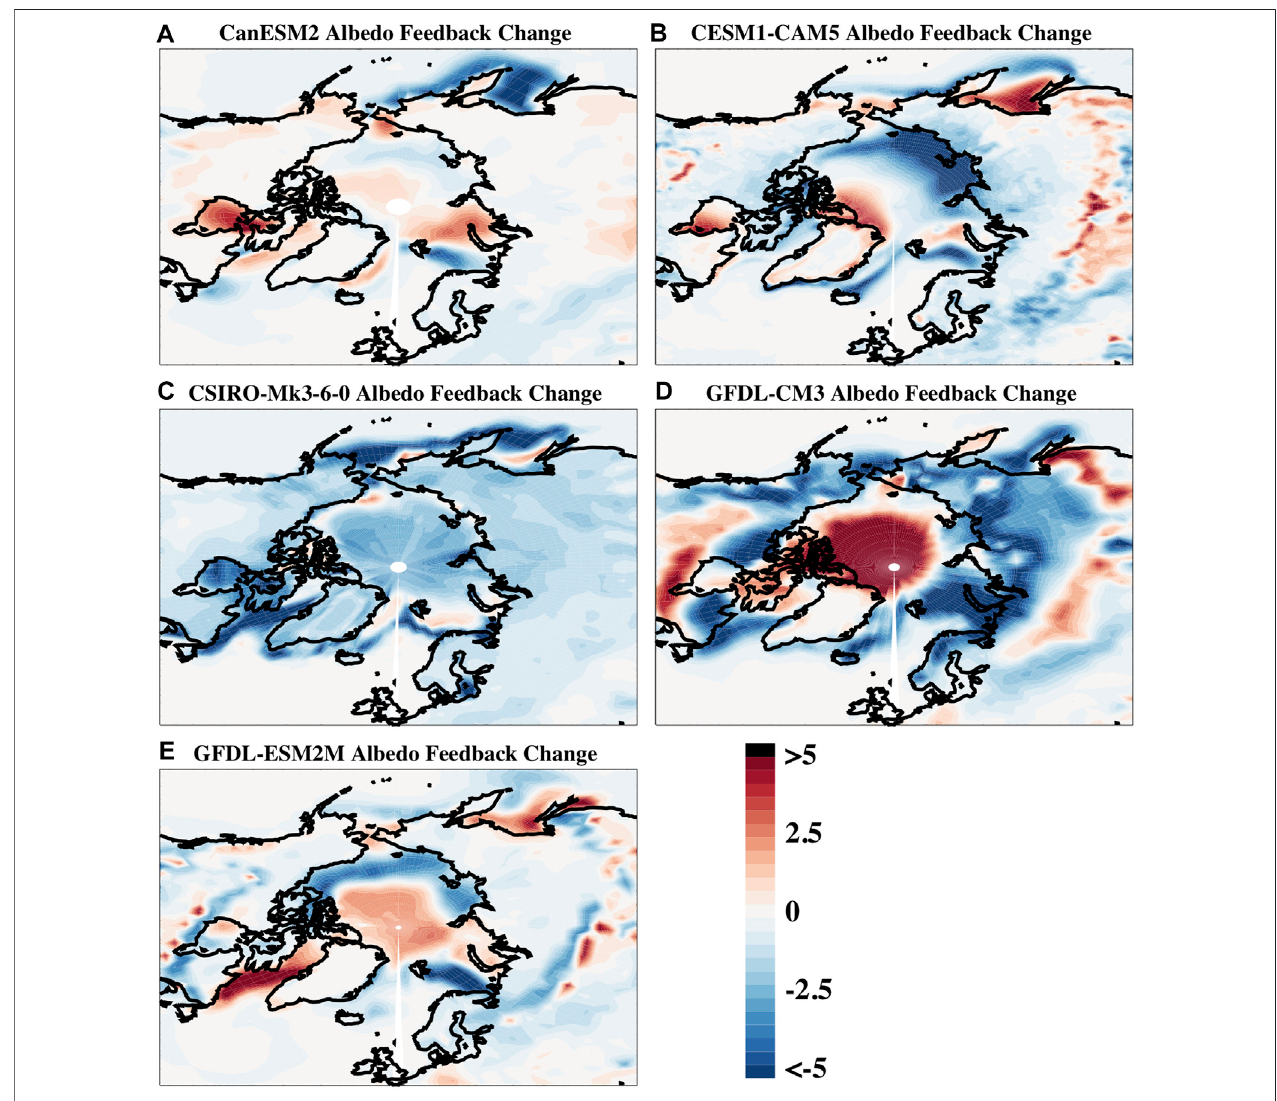
FIGURE 10 | The changes in the ensemble mean surface albedo feedback for the 2090 – 2099 decadal average minus the 2000 – 2009 decadal average for the different models including (A) CanESM2, (B) CESM-CAM5, (C) CSIRO-Mk-3-6-0, (D) GFDL-CM3, and (E) GFDL-ESM2M. Values are shown in W m − 2 K − 1 .